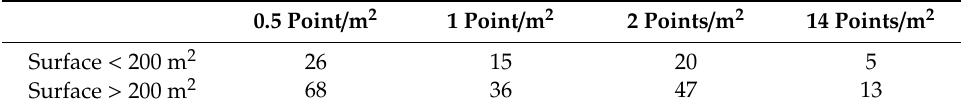
Table 6. Average RMSE (m 2 ) per point cloud density for industrial Figure 9. Mean relative error (%) for buildings with a surface <200 m 2 and > 200 m 2 : ( a ) industrial use ( b ) residential use.